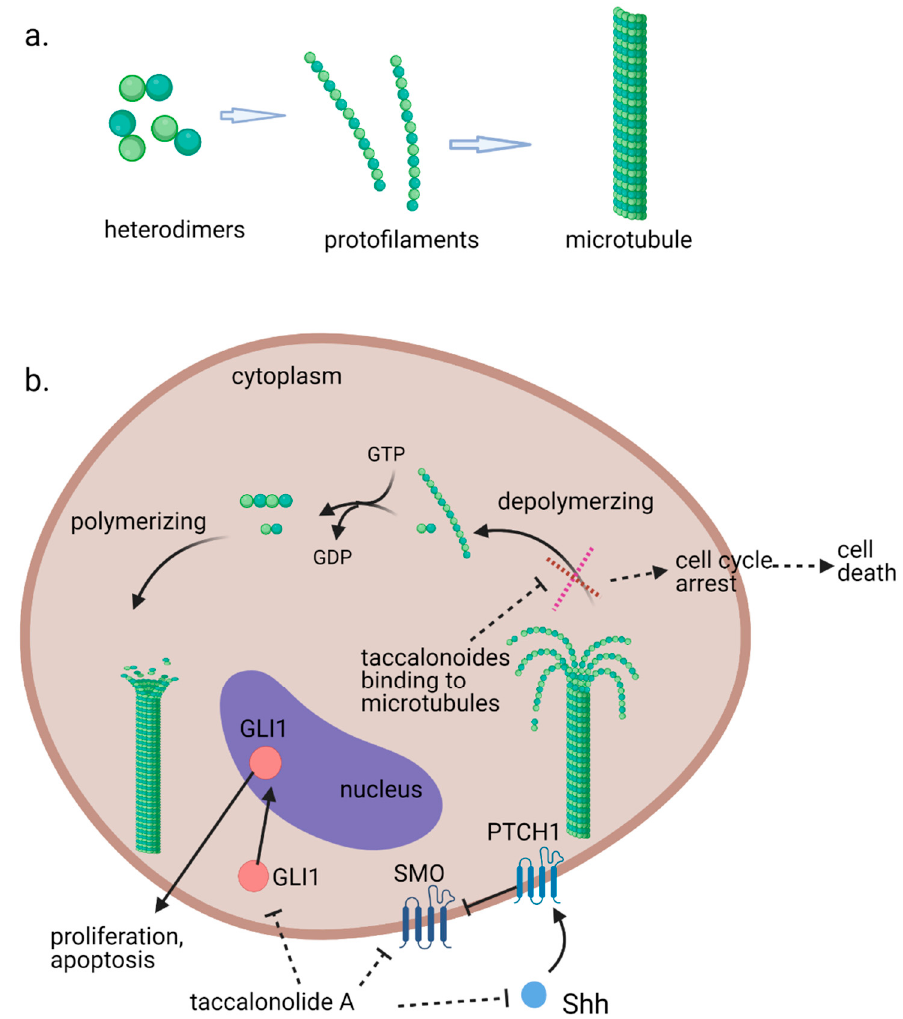
Figure 1. ( a ) . Fundamental aspects of microtubule structure. ( b ). The dynamic behavior of mi- crotubules and mechanism of action of microtubule stabilizing agents e.g., taccalonolides. In a recent study, it is observed that mRNA and protein expression levels of sonic hedgehog (Shh), SMO and GlI1 were decreased in HepG2 and Huh7 cells treated with taccalonolide A. polarity. Aberrant activation of the Shh pathway has been shown in a variety of human cancers. Block- age of Shh pathway induces inhibition of downstream protein smoothened (SMO) at the pri- mary cilium resulting in the decreased nuclear localization of glioma-associated (GLI) tran- scription factors, preventing the activation of GLI target genes [14]. Diagrams were created with BioRender.com (accessed on 12 February